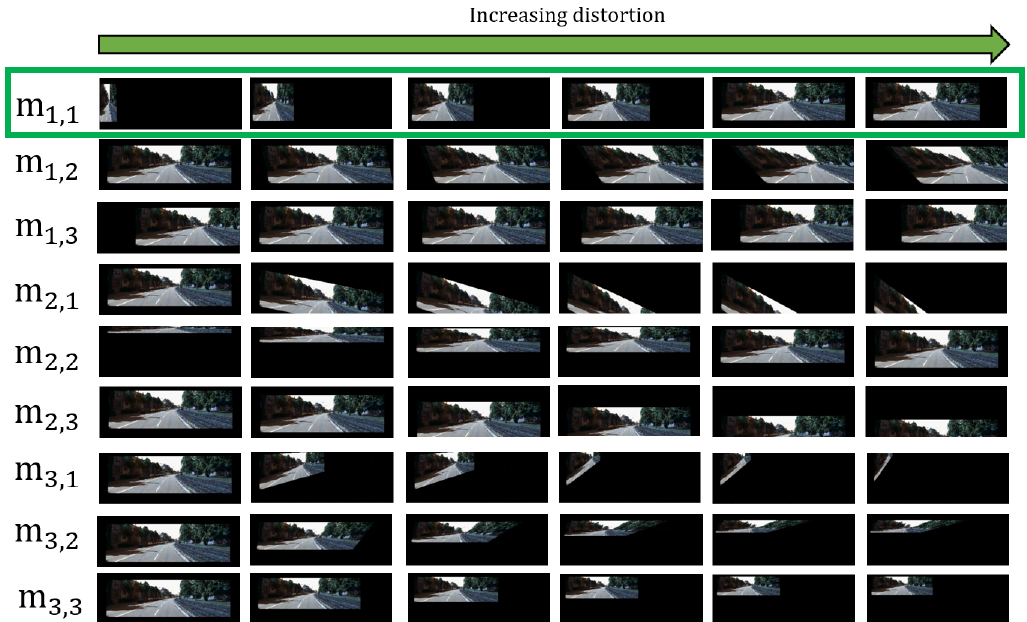
Figure 3. Effects of each element in M to an input image shown frame by frame. The frames for each element in M are generated by repeatedly increasing its element values. For example, the frame animations for m 1,1 are generated by as m 1,1 increases from 0 to 1 while all other entries in M are made constant. The same procedure is performed for creating the animations for the other